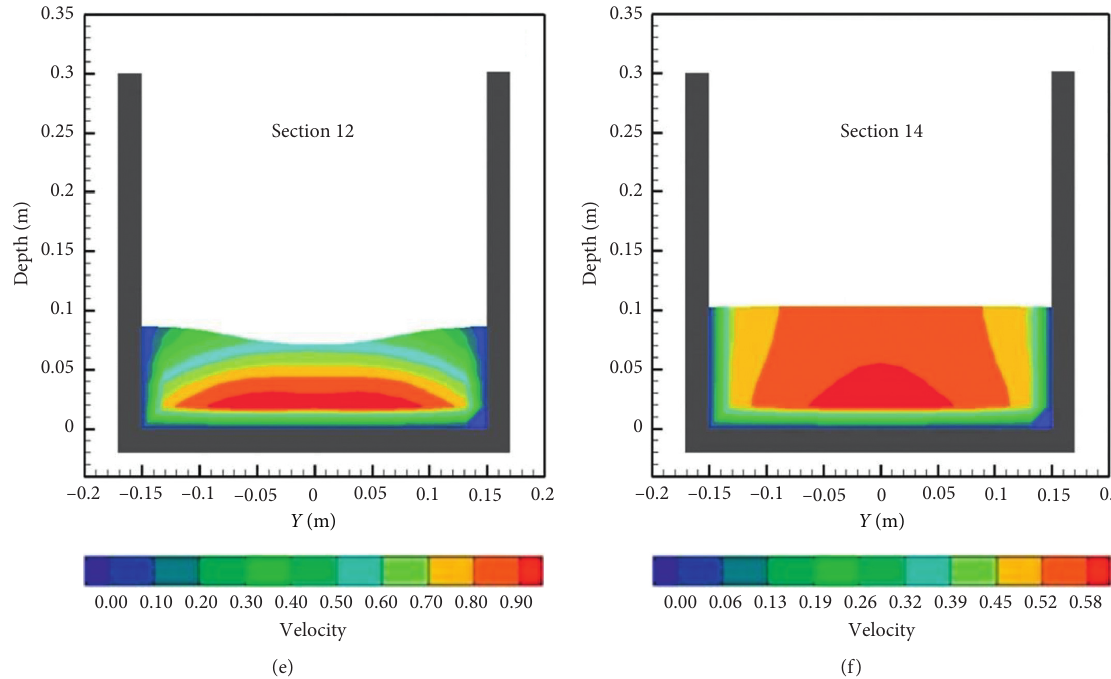
Figure 16: Development of the cross-sectional velocity distributions of the longitudinal flow of the water at a flow rate of 15L/s and a contraction ratio of 0.5 (unit: m · s − 1